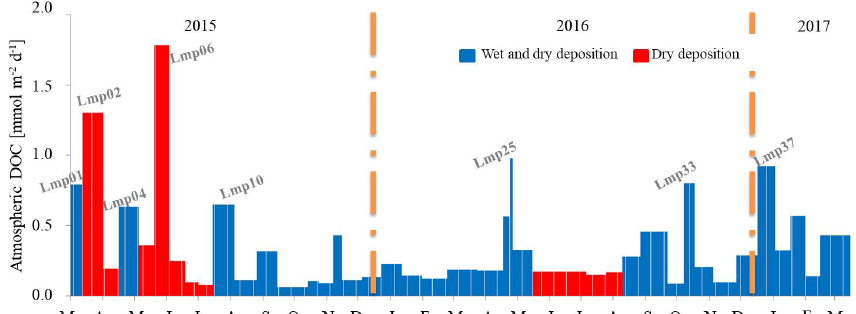
Figure 2. Atmospheric DOC fluxes during the study period. The month abbreviation and tick marks correspond to the end of the correspond- ing month. The width of the bar refers to the length of the sampling period. Wet and dry deposition is indicated in blue; dry deposition is indicated in red.